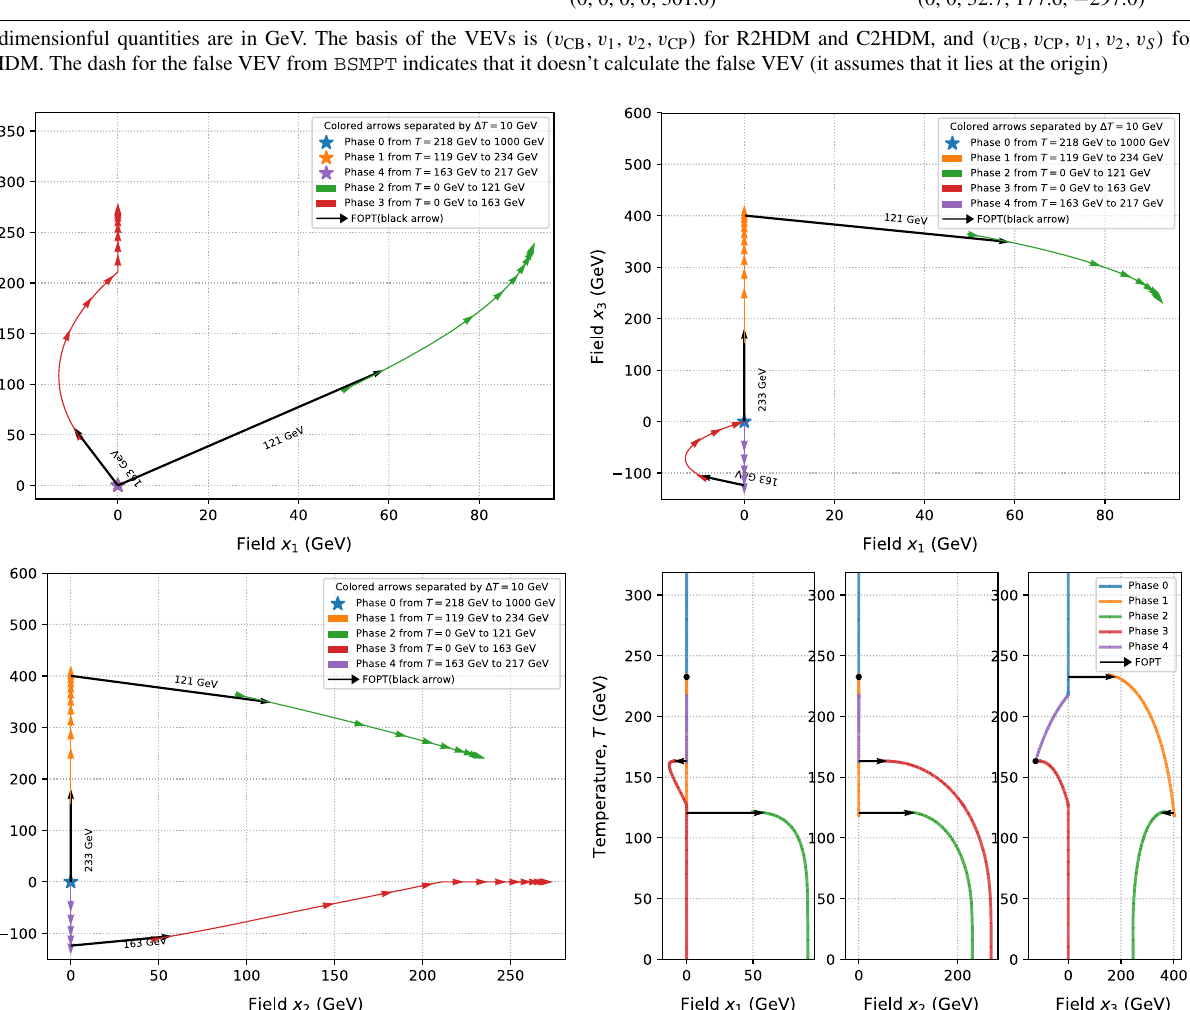
dots represent transitions that do not change the corresponding field values. The labels x 1 , x 2 and x 3 were autogenerated by our plotting code. In this example they stand for h u , h d and s ,